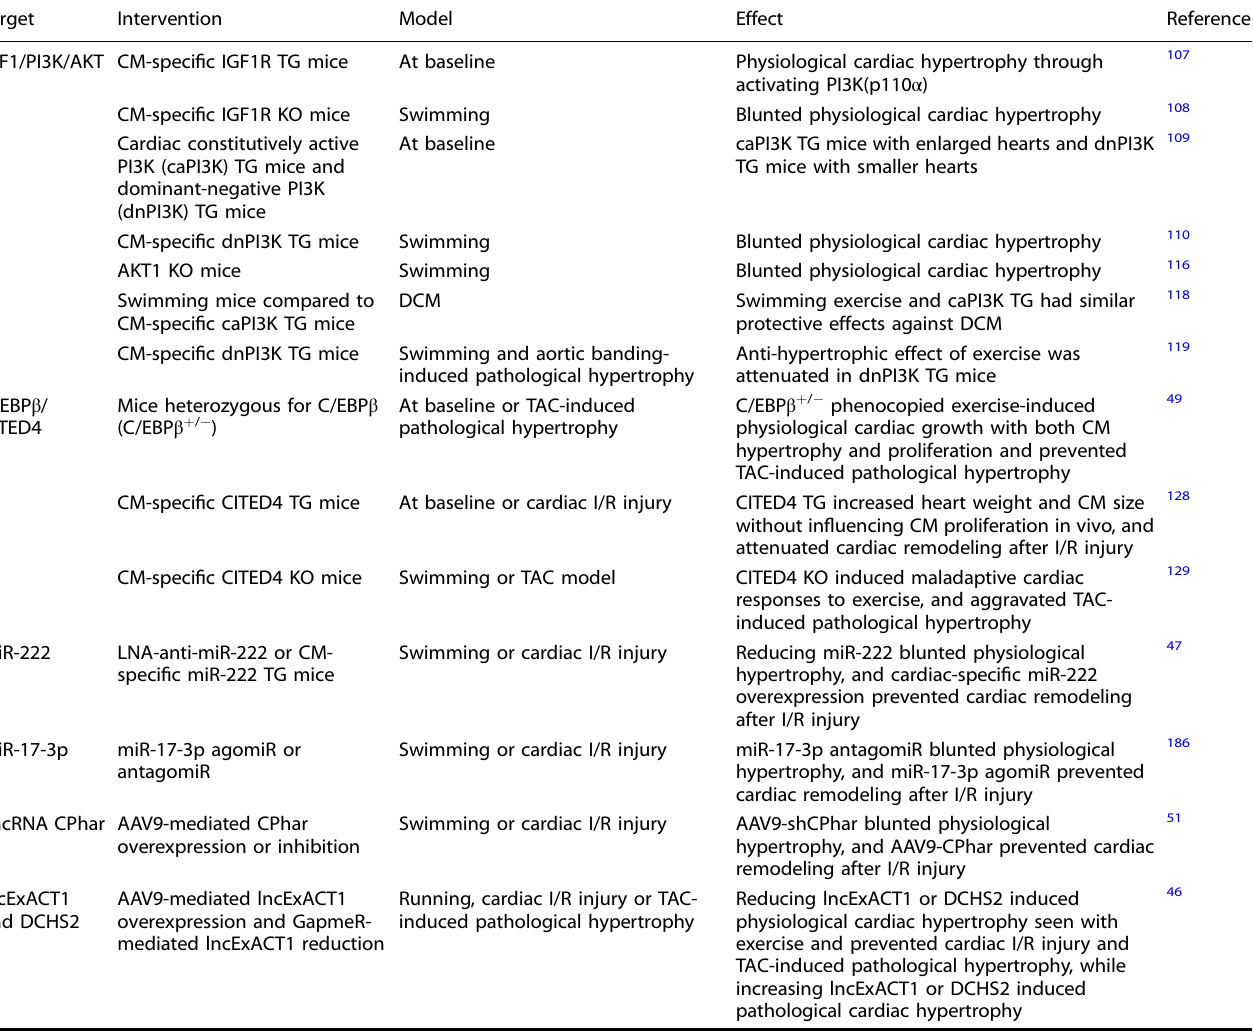
Table 1. Signaling pathways and molecules involved in exercise-induced cardiac hypertrophy and their contributions to cardioprotection